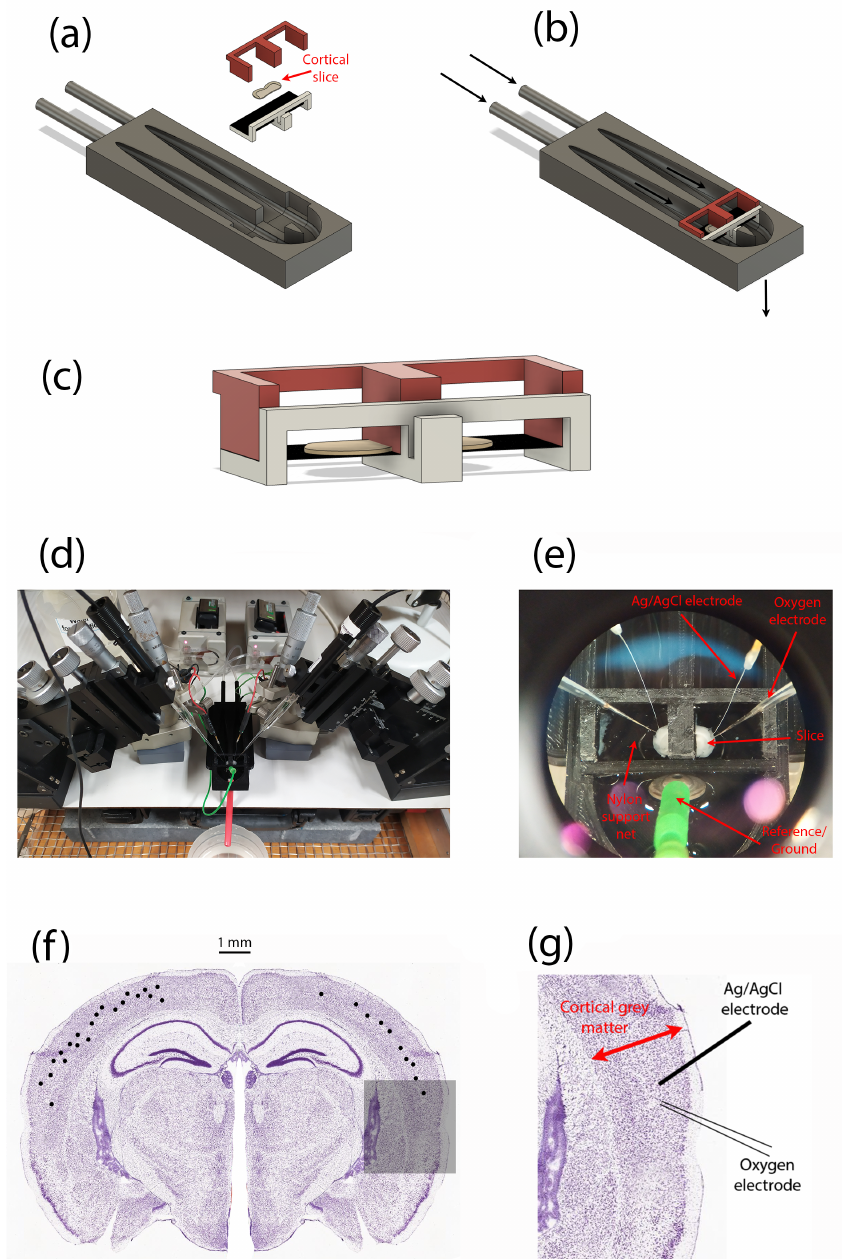
Figure 5. Perfusion bath and experimental setup for measuring oxygen-pressure profiles within a thin slice of mouse cortical tissue. ( a ) Exploded CAD model showing the separate components of the dual-compartment slice perfusion apparatus. ( b ) Assembled perfusion bath; arrows indicate direction of solution flow. ( c ) Enlarged view of the brain slice (grey ‘pancake’ shape) and its support structures; the slice sits on a nylon net (shown as a black-shaded horizontal surface). ( d ) Overview of experimental setup showing left and right pairs of micromanipulators, local-field potential (LFP) electrodes, oxygen probes. ( e ) Zoomed view of in situ cortical slice sitting on nylon net, and probed by LFP (Ag/AgCl wires) and oxygen (glass) electrodes. ( f ) Distribution of recording locations (black dots) within the slice cerebral cortex. For illustrative purposes, locations are shown on a single slice (but slices anterior to the one shown were used in some cases). Repeat profiles captured from some locations are not differentiated. ( g ) Representative arrangement of LFP electrode and oxygen probe for a single recording location, expanded from the shadowed region in ( f